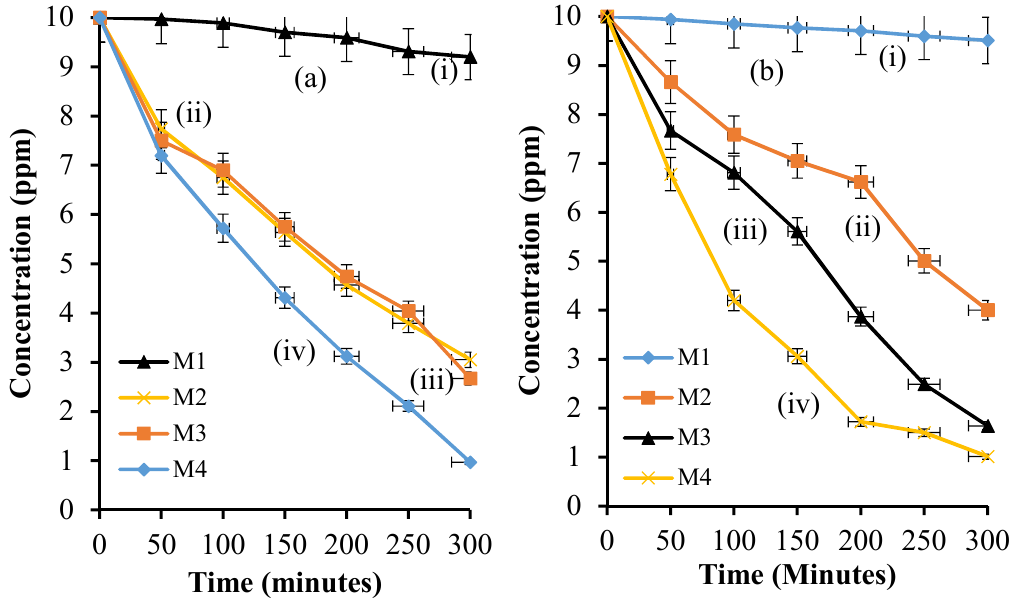
Figure 7. Photodegradation profiles for ( a ) MO and ( b ) GY, obtained using ( i ) pristine PAN (M1), ( ii ) 1%C-TiO 2 -CFA/PAN membrane (M2), ( iii ) 1.5%C-TiO 2 -CFA/PAN membrane (M3), and ( iv ) 2%C-TiO 2 -CFA/PAN membrane (M4), under sunlight irradiation (108,600 lux of light intensity).